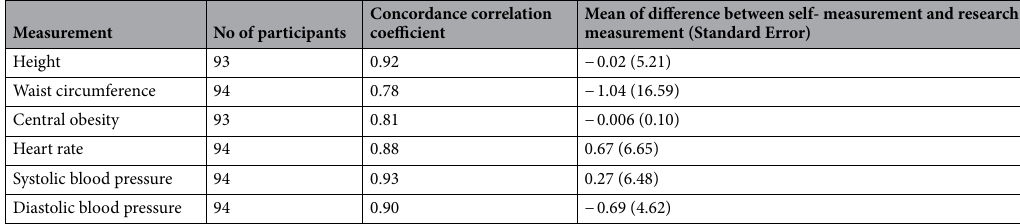
Table 2. Agreement between self-measurement and researcher measurement for continuous measurements.